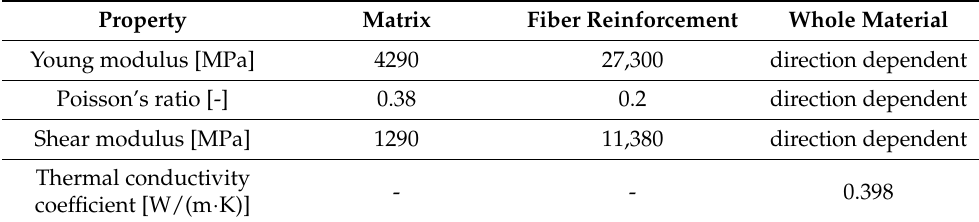
Table 1. Material properties of the hybrid composite friction